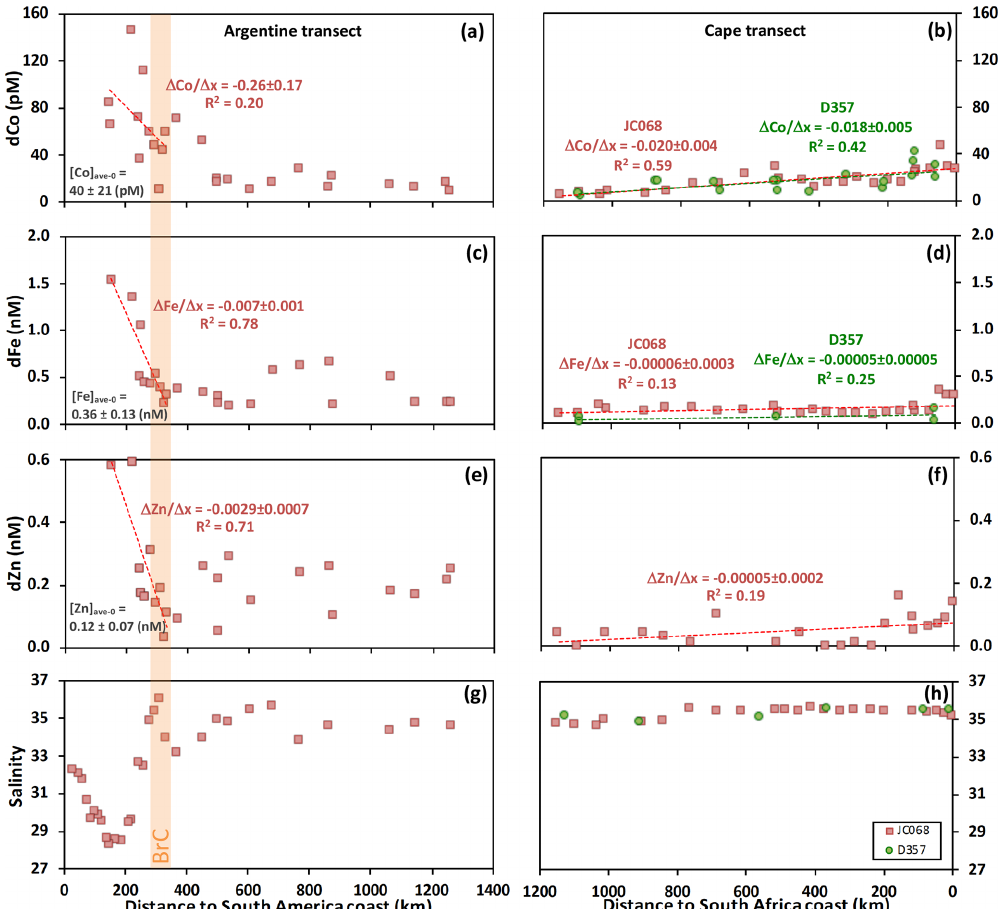
Figure 3. Dissolved trace elements (dCo, dFe, and dZn) and salinity in the surface water ( < 10m) along the 40 ◦ S Argentine and Cape Basin transects. Red squares show data from cruise JC068, and green circles show data from cruise D357. The orange band indicates the boundary of the BrC in the Argentine Basin transect, highlighted by high salinity and changing TE gradients. [TE] ave − 0 is the average concentrations of dissolved TEs in the initial advective waters around where the Brazil Current merges into the SAC (around Stn21; ± 1SD, n = 4). The dashed lines show linear regression trends through the TE data (Argentine Basin transect: only data from the shelf to BrC; Cape Basin transect: the whole transect), and the gradient ( (cid:49) TE /(cid:49)x ) errors are ±